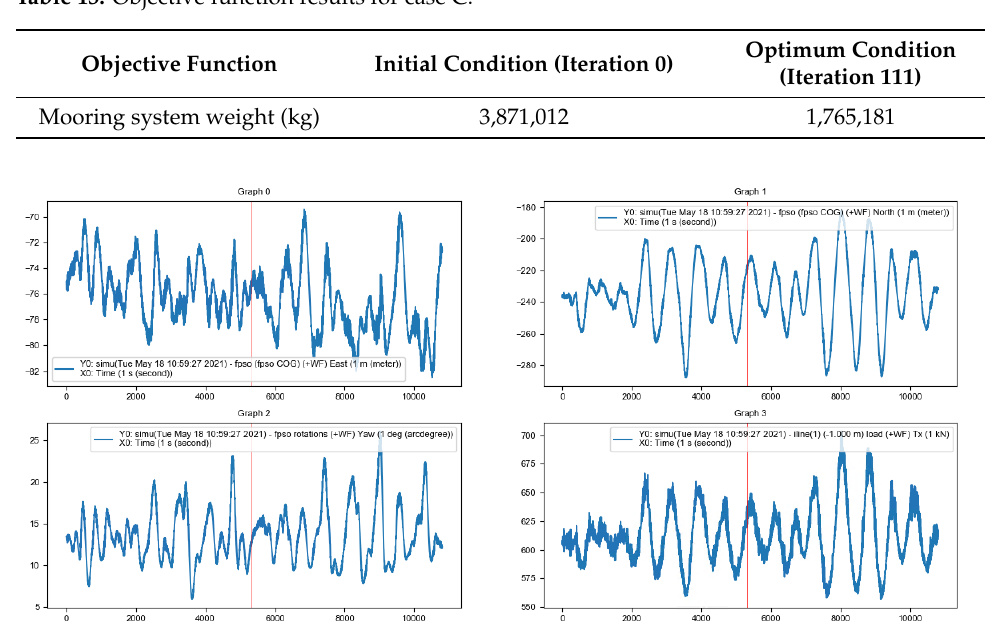
Figure 11. Time series of FPSO motions (Sway ( top left ), Surge ( top right ), Yaw ( bottom left ) and mooring line tensions ( bottom right ) at the optimized case.